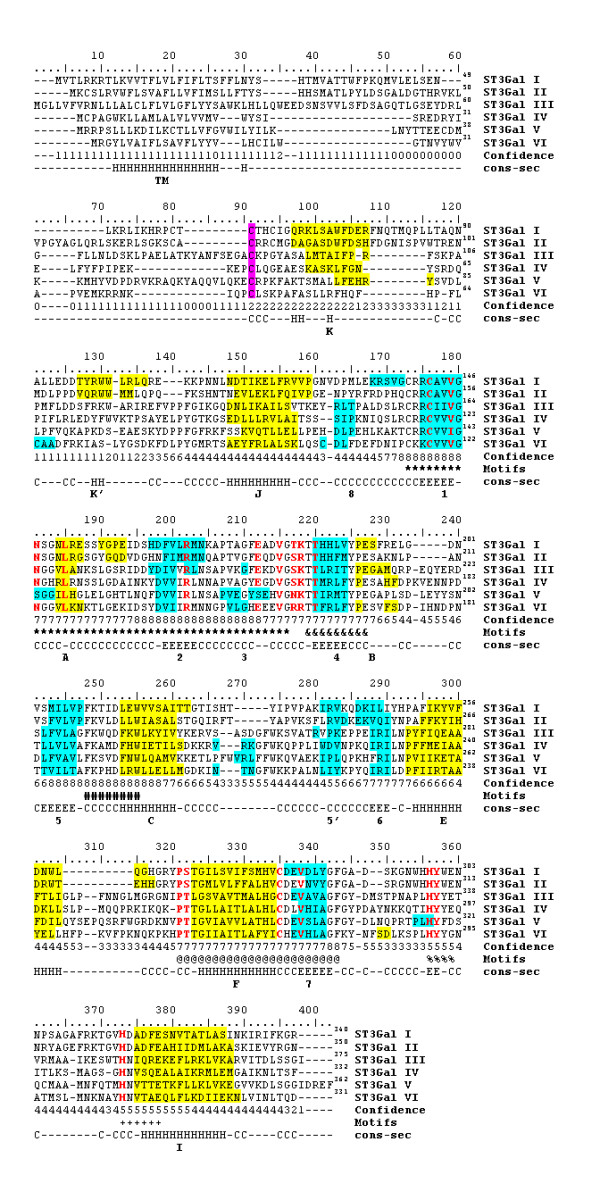
Multiple sequence alignment of ST3Gals (Table 1) obtained from the Tcoffee server [41]. A hyphen (" - ") indicates a one-residue gap. The ruler at the top is for the entire alignment and has no reference to any individual sequence; the latter are numbered on the right. The residues constituting the various motifs are marked below: L-motif (alignment position 173–216, denoted by *), linkage-specific motifs (219–227, denoted by & and 248–255, denoted by #), S-motif (321–343, denoted by @), motif III (356–359, denoted by %) and VS-motif (373–378, denoted by +). The structural and functionally important residues identified by mutation studies (Table 2) have been highlighted in red with bold font. Confidence is the confidence score given by Tcoffee. The regions having the same secondary structure in all the ST3Gals are also shown (marked cons-sec for consensus secondary structure). The names of the various strands and helices, indicated below the consensus secondary structure, are the same as those of the corresponding regions in CstII [13]. Residues highlighted in yellow and cyan constitute α-helices and β-strands, respectively, (as identified by SwissPDBviewer/RasMol) in at least one of the top models. The conserved cysteine residue in the stem region is highlighted in pink.